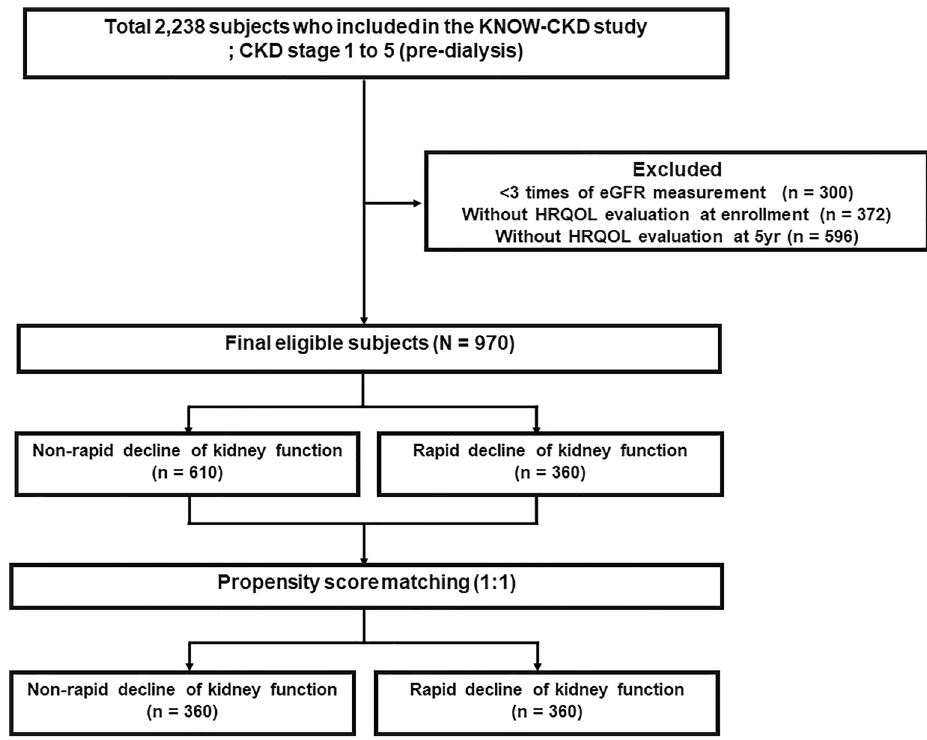
Figure 1. Flow chart of patient enrollment and analyses. CKD, chronic kidney disease; eGFR, estimated glomerular filtration rate; HRQOL, health-related quality of